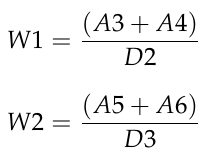
Table 7. Normalized widths of the second and third absorption bands in T1 and T2.